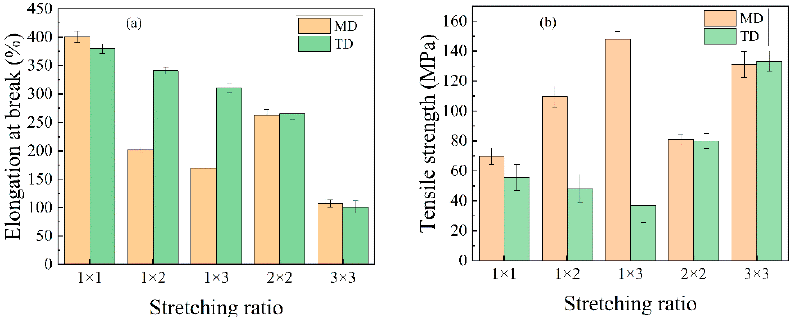
Figure 11. The mechanical properties of PA510/SiO 2 films at various stretching ratios: ( a ) elongation at breaking and ( b ) tensile strength.